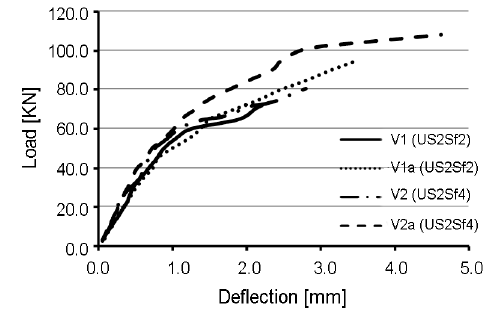
Fig. 10. Load–deflection relationship for tested